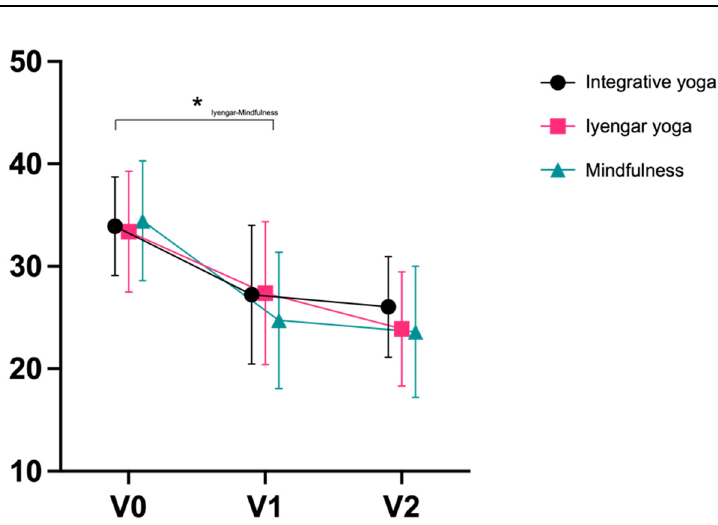
Figure 4. Exhaustion MBI (Mean ± SD). * = p < 0.05